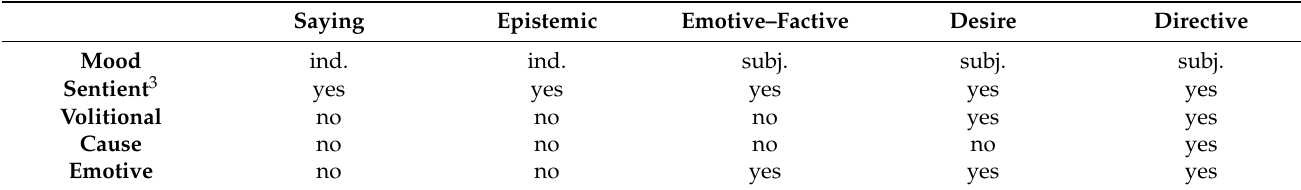
Table 1. Semantic decomposition of verbs selecting tensed CPs in French.